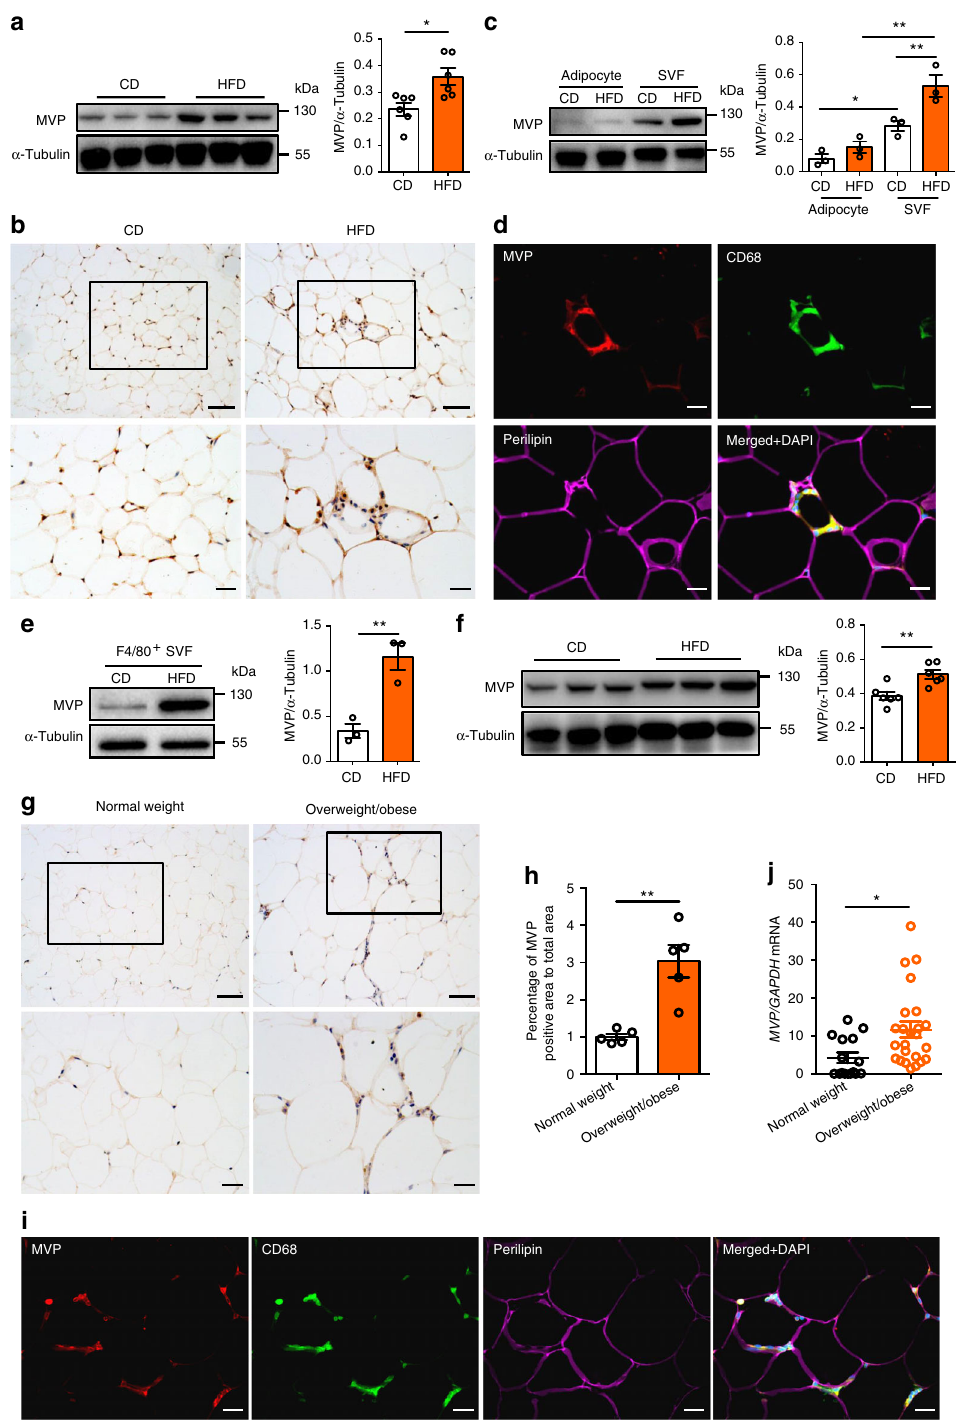
Fig. 1 MVP expression is up-regulated in macrophages from obese mice and human beings. Male C57BL/6J mice were fed a CD or a HFD for 12 weeks. a Western blot analysis of MVP expression in epiWAT ( n = 6). b IHC staining of MVP in epiWAT. Scale bars, 50 μ m (top) and 20 μ m (bottom). c Western blot analysis of MVP expression in the adipocytes and SVFs isolated from epiWAT ( n = 3). d Immuno fl uorescence images of staining with antibodies against CD68 (green), MVP (red), and Perilipin (purple) in epiWAT of HFD-fed mice. Nuclei were stained with DAPI (blue). Scale bars, 20 μ m. e Western blot analysis of MVP expression in sorted F4/80 + macrophages isolated from epiWAT SVFs ( n = 3). f Western blot analysis of MVP in PMs ( n = 6). g , h IHC staining ( g ) and quantitative analysis ( h ) of MVP in the visceral adipose tissue from normal weight donors and individuals with overweight or obesity ( n = 5). Scale bars, 50 μ m (top) and 20 μ m (bottom). i Representative immuno fl uorescence images of staining with antibodies against CD68 (green), MVP (red), and Perilipin (purple) in visceral adipose tissue of overweight or obese individuals. Nuclei were stained with DAPI (blue). Scale bars, 20 μ m. j mRNA level of MVP in CD14 + macrophages isolated from the visceral adipose tissue SVFs of normal weight (18.5 ≤ BMI < 24, n = 15) and overweight (24 ≤ BMI < 28) or obese (BMI ≥ 28) ( n = 24) subjects. Data are expressed as mean ± SEM. * P < 0.05 and ** P < 0.01 by Student ’ s t test or ANOVA with post hoc